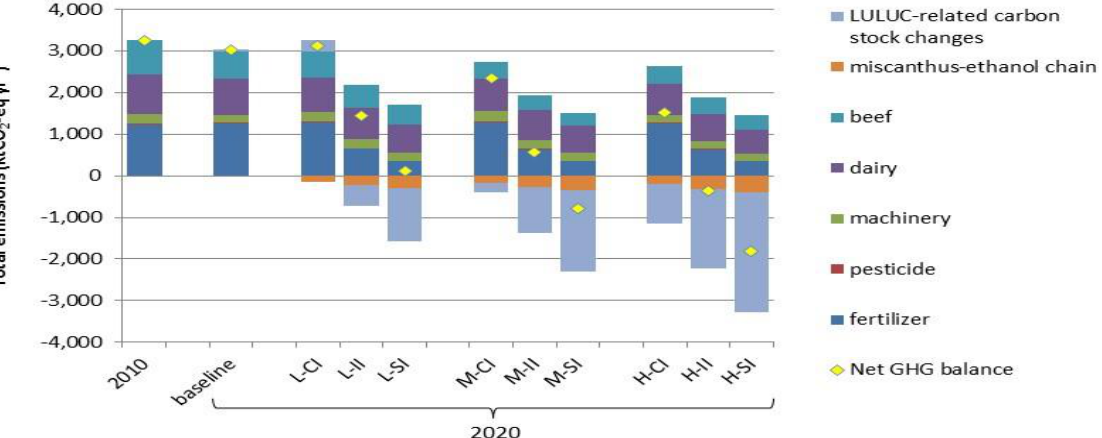
Figure 3. Total and net annual GHG emissions for 2010 and the baseline and ILUC mitigation scenarios in 2020. Emissions from the miscanthus – ethanol value chain. The equilibrium time for soil carbon stock changes is 20 years (taken from: Gerssen Gondelach et al. [43,44]). ILUC prevention scenarios: L — low; M — medium; H — high. Intensification pathways: CI — conventional intensifica-